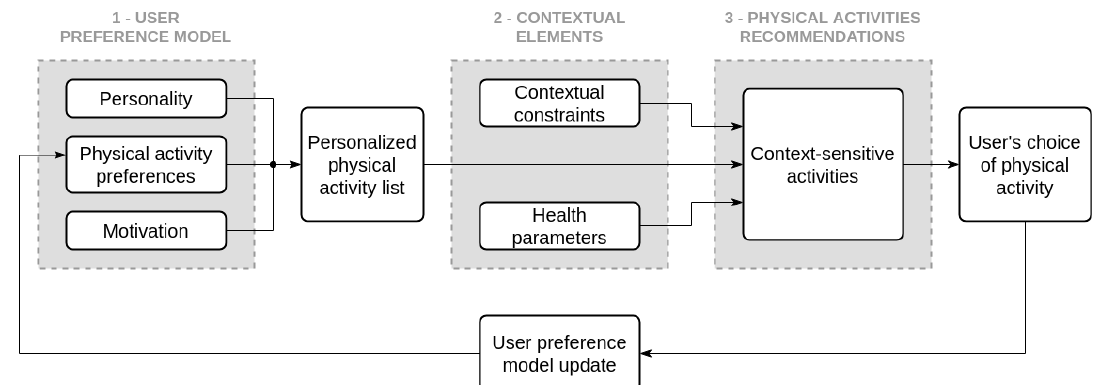
Figure 6. Personalized and Adapted Activities Suggestions Process: this figure details how a self-quantification system for physical activity support should rely on a user preference model of activities, (1) before filtering it with monitored contextual elements (2) in order to produce its recommendations (3). A personalized list of context-sensitive activities is proposed to the user from which they can